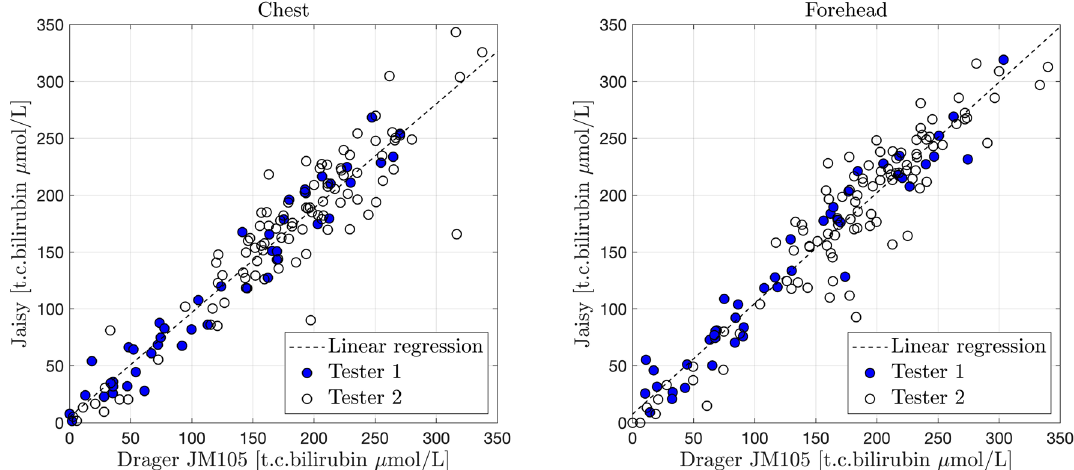
Figure 2. Correlation between t.c. bilirubin values (μmol/L) measured with JM105 and JAISY in the chest (β = 0.92, r = 0.94, p < 0.001) and forehead (β = 0.97, r = 0.94, p < 0.001) of 141 newborn infants (gestational